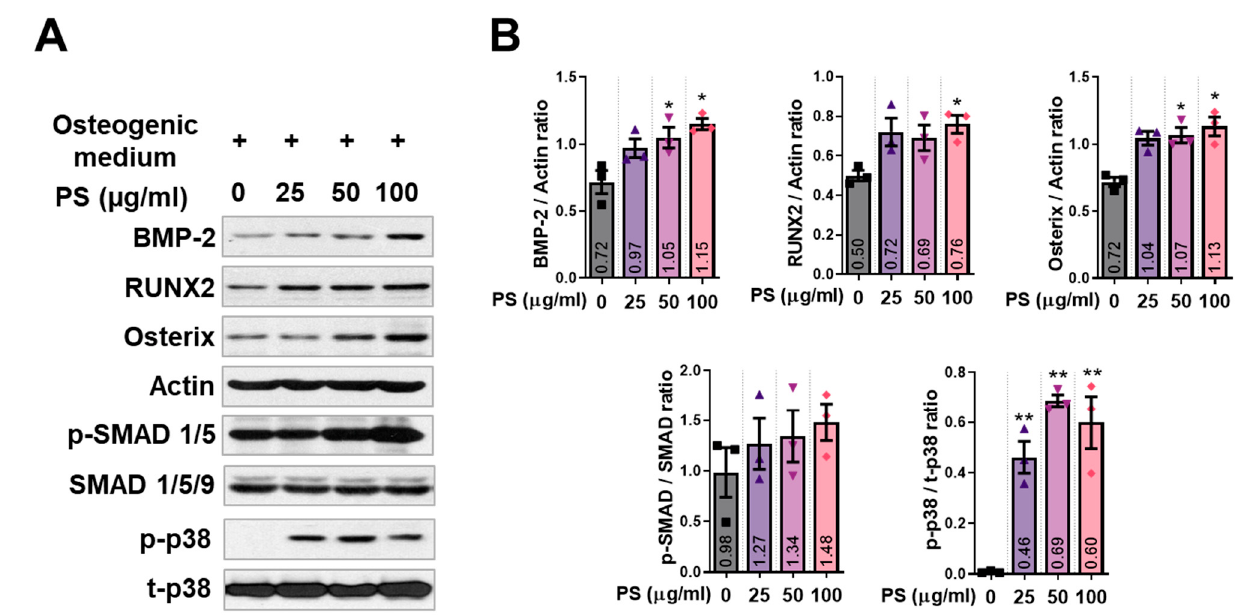
Figure 2. BMP-2 signaling indicators and phosphorylation of p38 were elevated at the protein level in response to PS treatment. ( A ) The effects of PS on BMP, RUNX2 and osterix expression and the phosphorylation of SMAD and p38 were verified by Western blotting. ( B ) Each protein was quantified via comparison with actin, SMAD1/5/9 and t-p38. All experiments were repeated at least three times. The shapes (triangles, squares, etc) shown in each graph are values for each round of the experiment. Data are expressed as mean ± SEM. ** p < 0.01, * p < 0.05 versus the cells treated only with osteogenic medium.